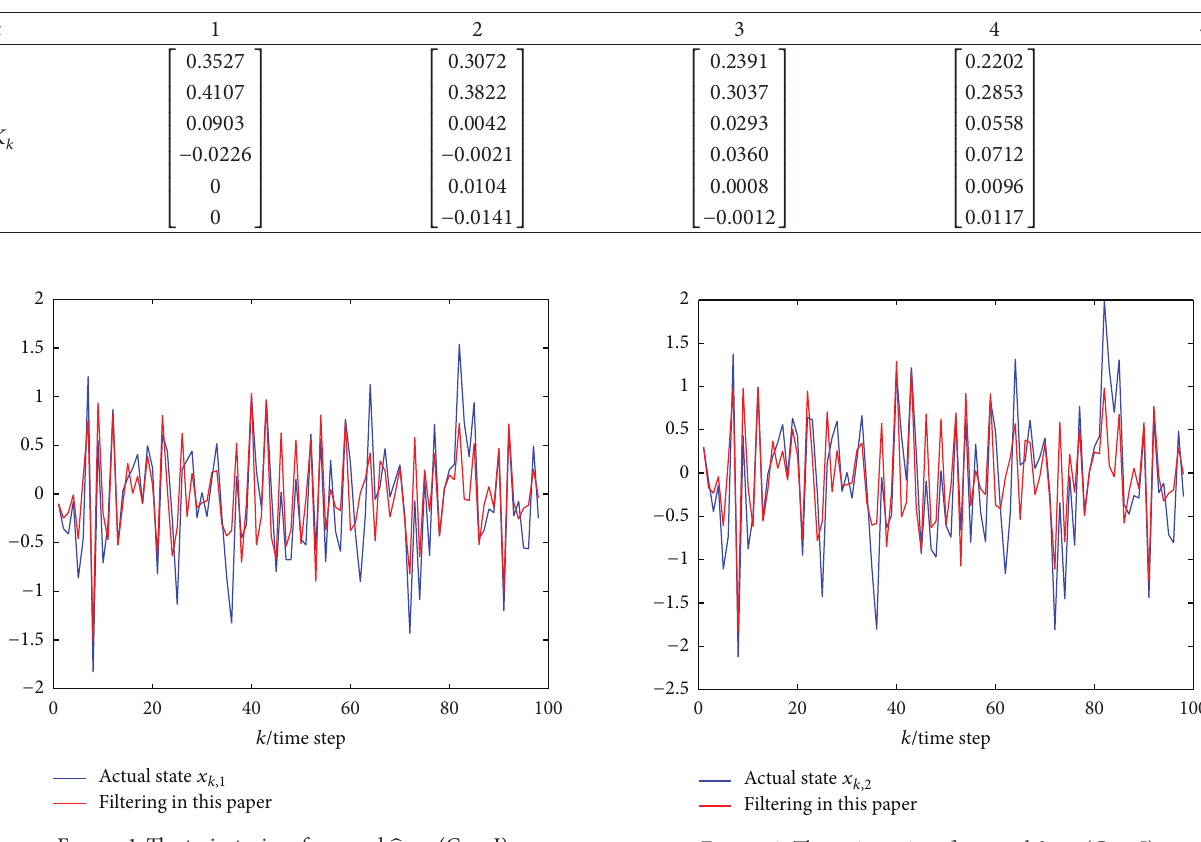
Figure 1: The trajectories of 𝑥 𝑘,1 and ̂𝑥 𝑘|𝑘,1 (Case I). Figure 2: The trajectories of 𝑥 𝑘,2 and ̂𝑥 𝑘|𝑘,2 (Case I).